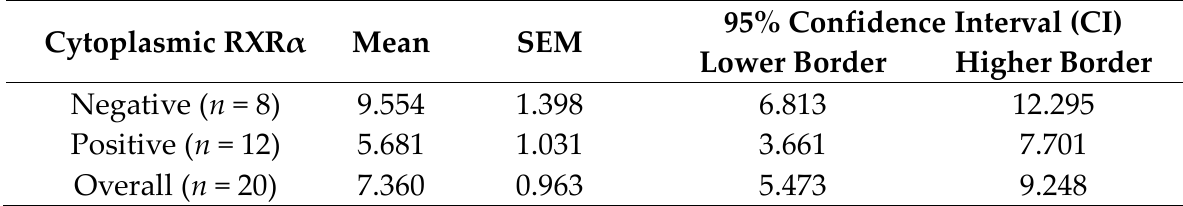
Figure 9. Kaplan – Meier survival analysis assessing cytoplasmic RXRα positive expression in the Figure 9. Kaplan–Meier survival analysis assessing cytoplasmic RXR α positive expression in the triple-negative patient triple-negative patient cohort in relation to OS. Statistical significance is shown as p -values deter- cohort in relation to OS. Statistical significance is shown as p -values determined using the log-rank test ( p < 0.05). The mined using the log-rank test ( p < 0.05). The risk table demonstrates the mean survival time in risk table demonstrates the mean survival time in triple-negative patients, SEM and the 95% confidence interval (CI) for triple-negative patients, SEM and the 95% confidence interval (CI) for univariate analyses. univariate